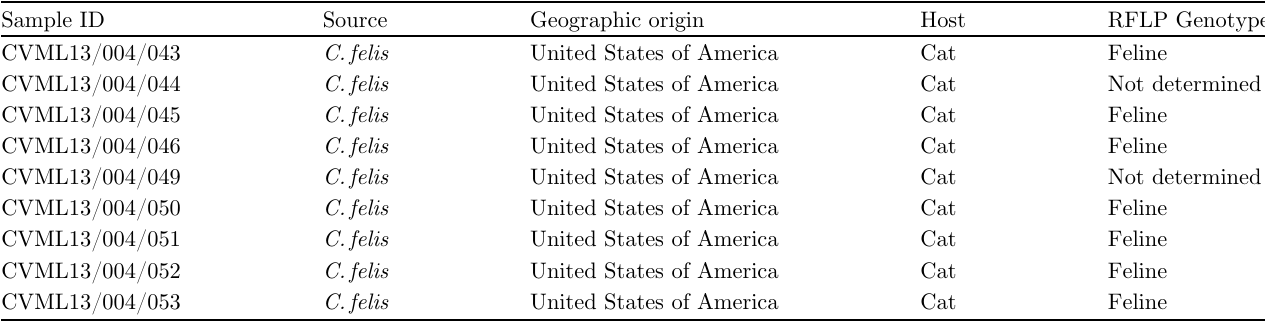
Table 2. Details on two distinct 28S rDNA sequence variants ( “ canine ” and “ feline ” ) de fi ned from fl eas infected by Dipylidium caninum , received from the United States of America.